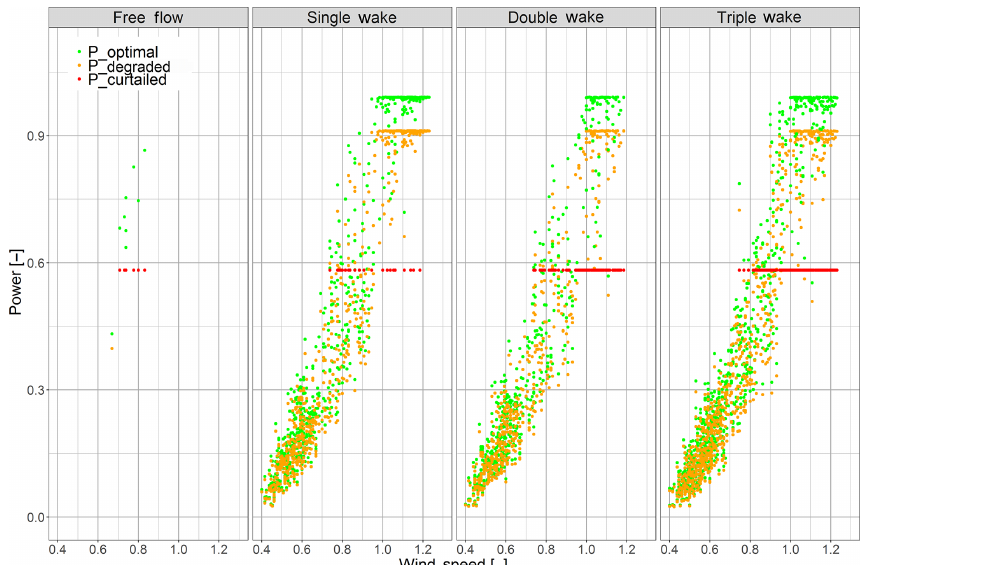
Figure 13. Scatterplot of each turbine’s normalized power curve. The quantity N = 754 equals the estimated sample size for the first detection of degradation at a turbine in a triple-wake situation.